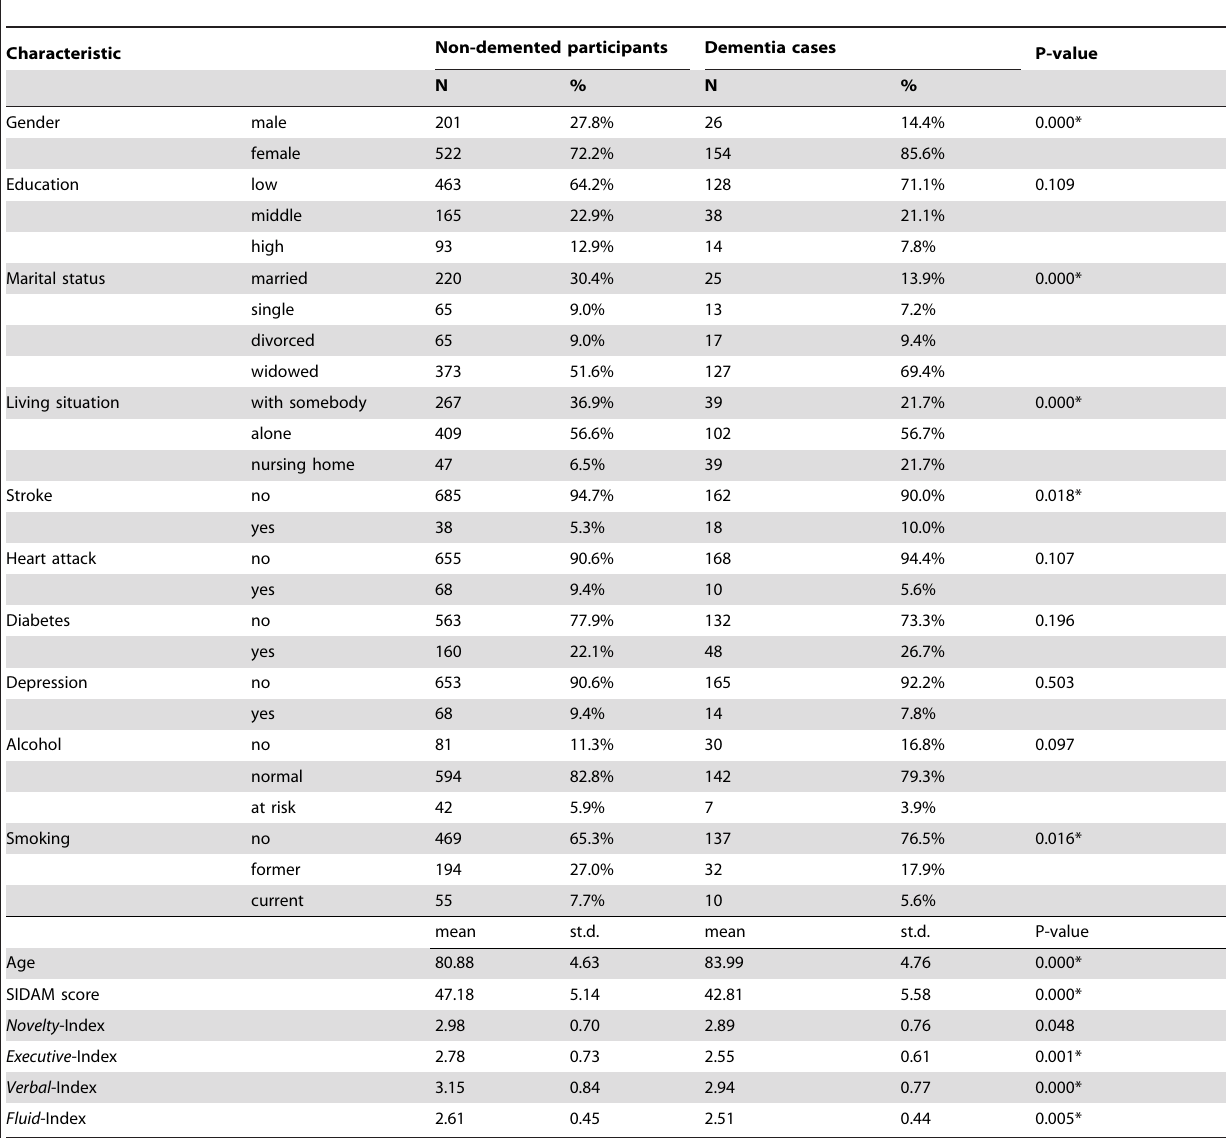
Table 1. Demographics and occupational context indices for dementia-free participants and dementia